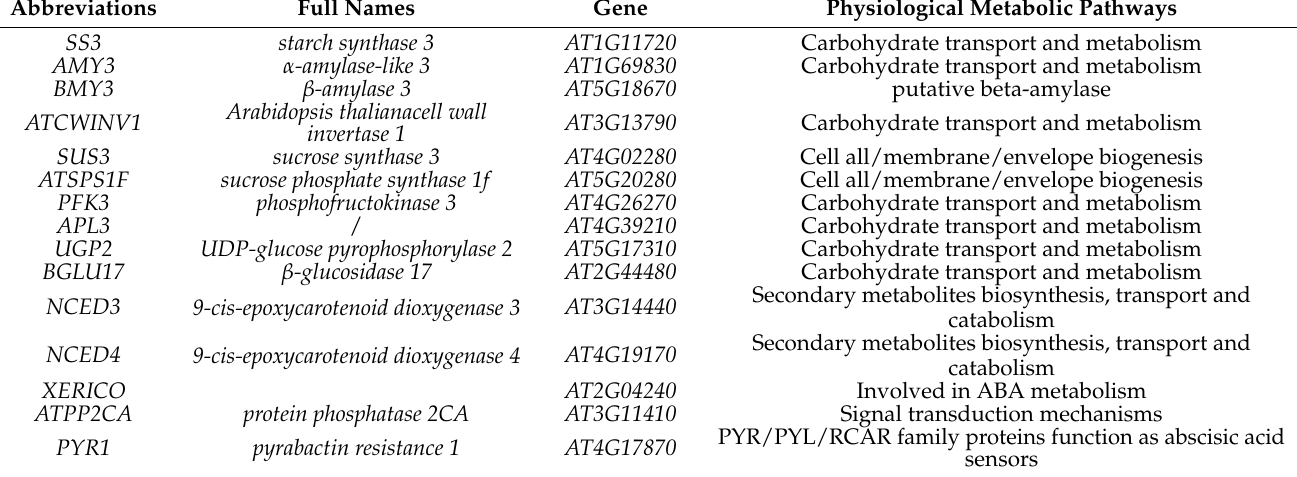
Table 2. Selection of genes related to carbohydrate metabolism, hormone metabolism and dormancy